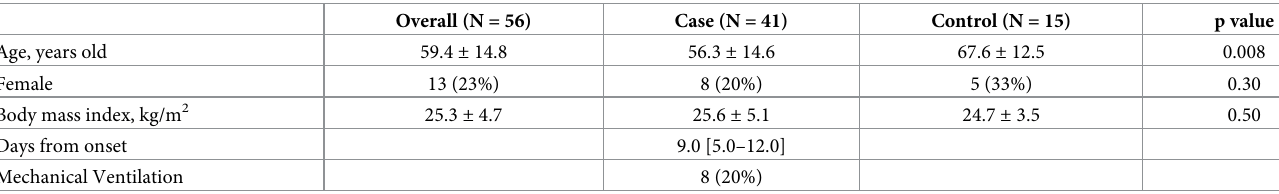
Table 1. Patient